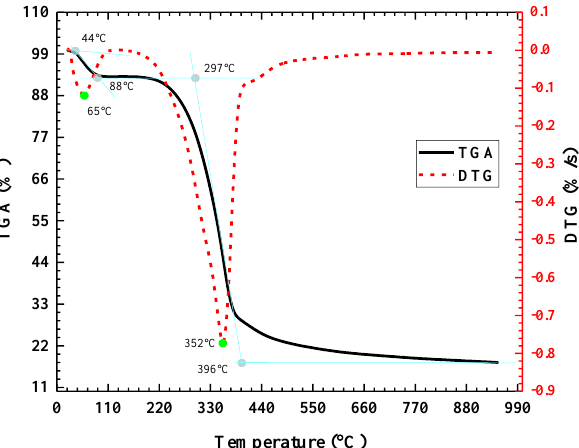
Figure 5. Thermogravimetric analysis results of pine wood under the condition of heating rate V T = 10 °C/min.